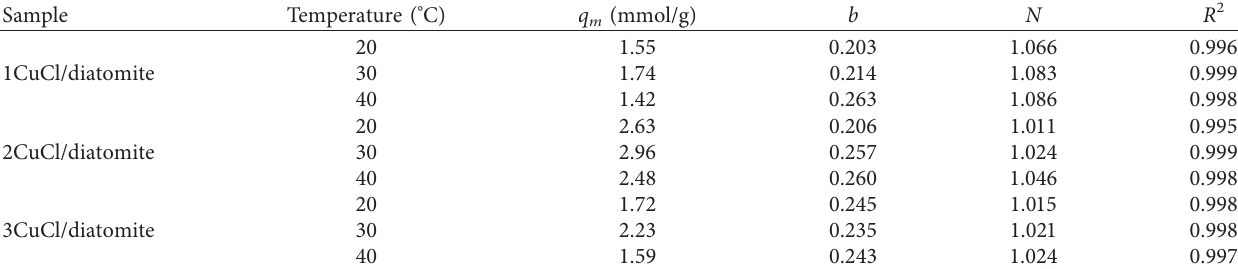
Table 4: Langmuir–Freundlich fitting parameters of carbon monoxide isotherms on CuCl-modified diatomites. Sample Temperature ( °